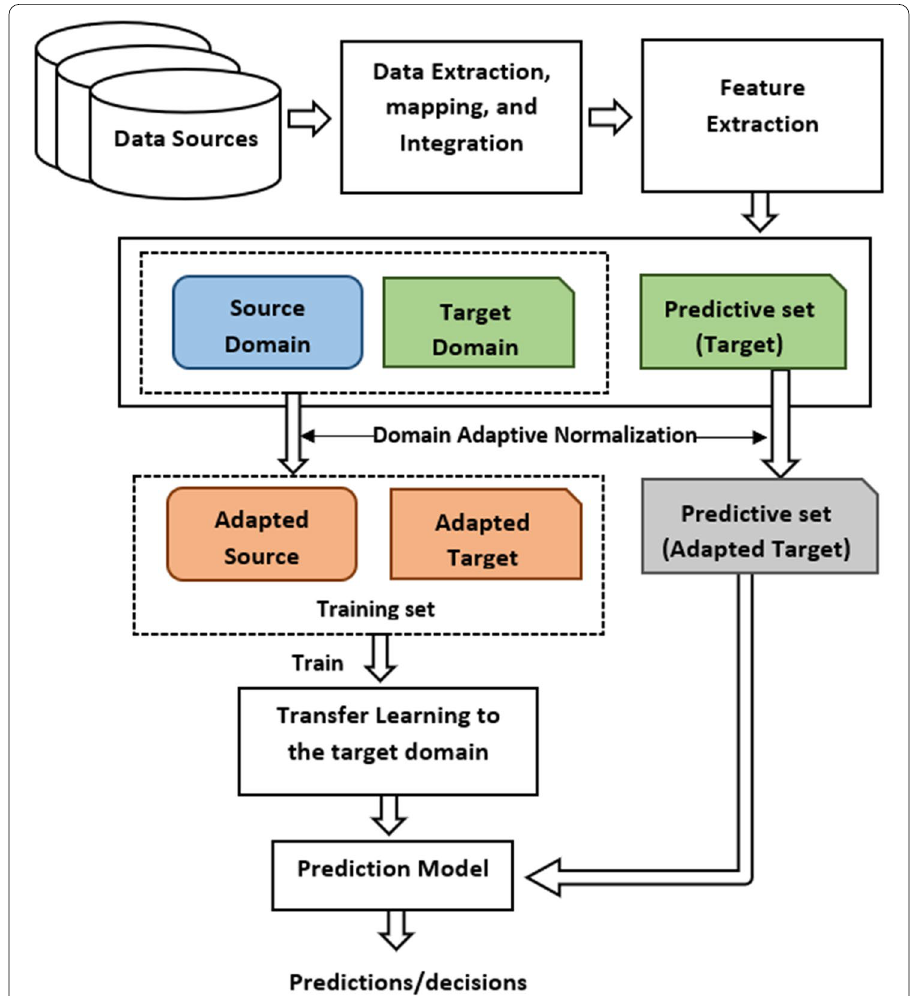
Fig. 1 The framework of our proposed cross-domain learning approach for crime prediction task. The source and target domains are defined by the rectangle rounded corner and single corner snipped shapes,